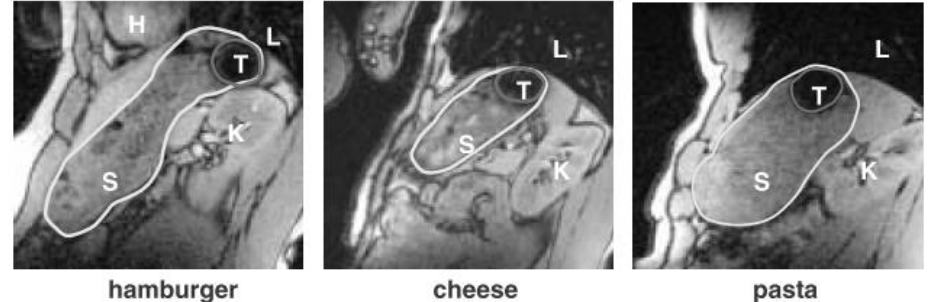
Figure 17. Magnetic resonance imaging of an iron-oxide-labeled floating tablet (T) in the stomach (S) on top of different meals. (H) heart, (K) kidney, (L) lung. Reprinted from Reference [42] with permission from John Wiley and Sons.